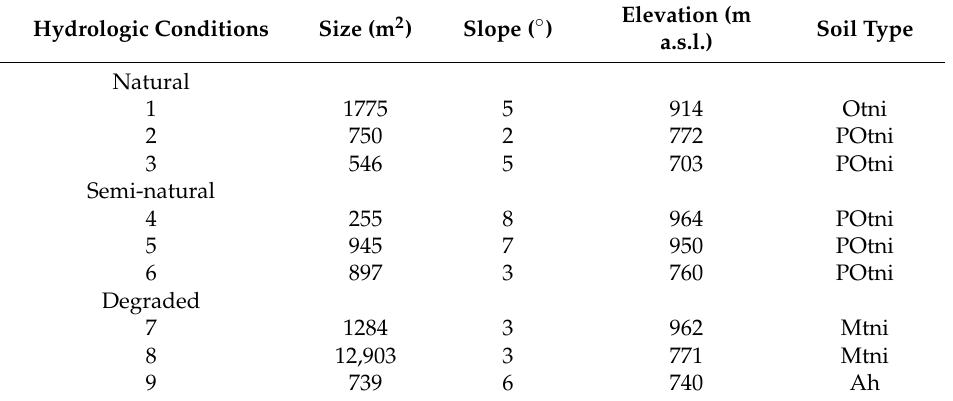
Elevation (m Soil Type a.s.l.)